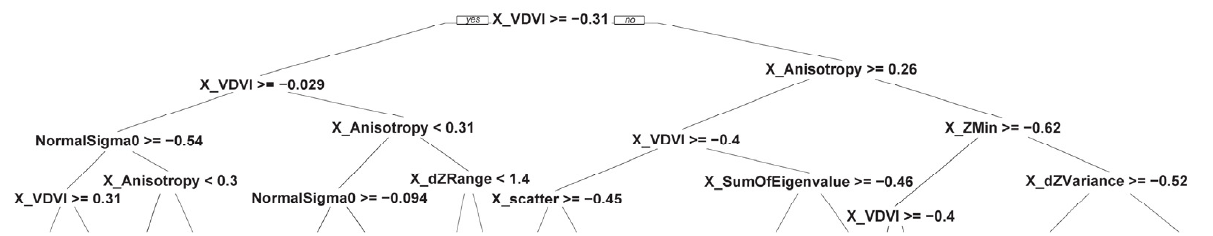
A detail with the mathematical classification model obtained after including the VDVI